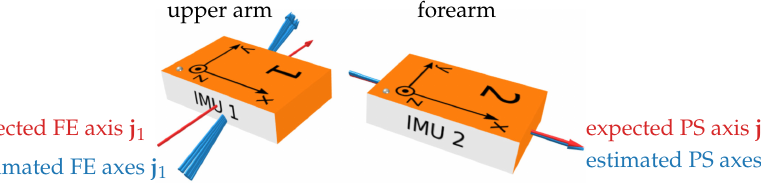
Figure 7. 3D visualization of the estimation results for an exemplary trial (Subject 2, simple motion, rotation-based constraint). The joint axis estimates from all windows agree well (blue arrows). The PS axis agrees very well with the expected value (red arrow), while for the FE axis there is a misalignment of 17 ◦ , most likely due to imprecise manual sensor